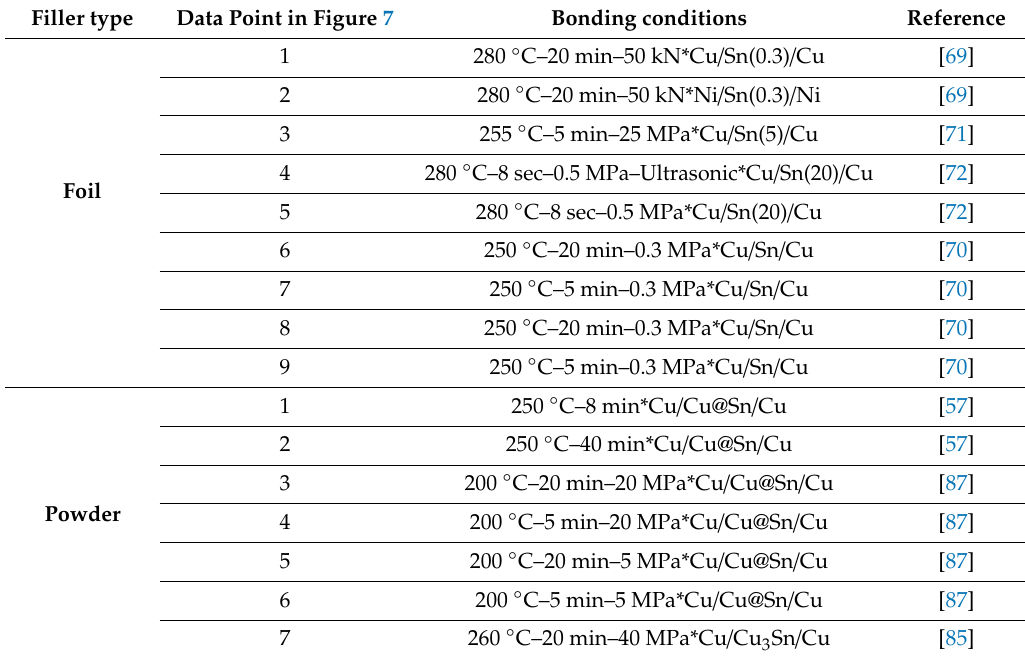
Table 2. TLP bonding conditions for powder and foil type interlayers related to Figure 7.